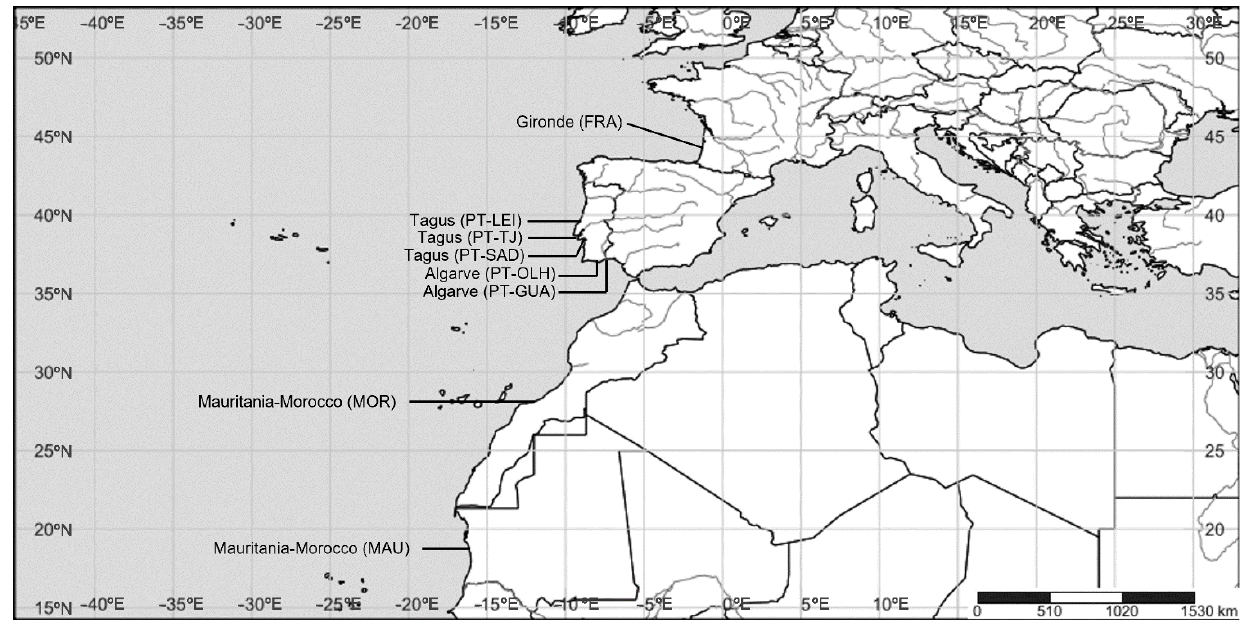
Figure 1. Locations of the Argyrosomus regius sampling sites and corresponding spawning areas. For location sites’ acronyms, please check Table 1 . Table 1. Sampling data for Argyrosomus regius individuals analyzed in this study. Sampled localities and spawning areas are presented from north to south as in Figure 1 .